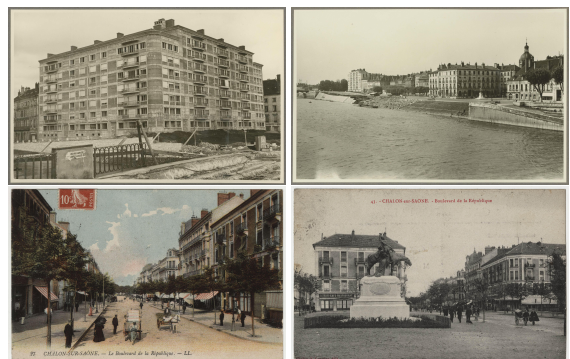
Figure 1. Sample photographs/postcards from the